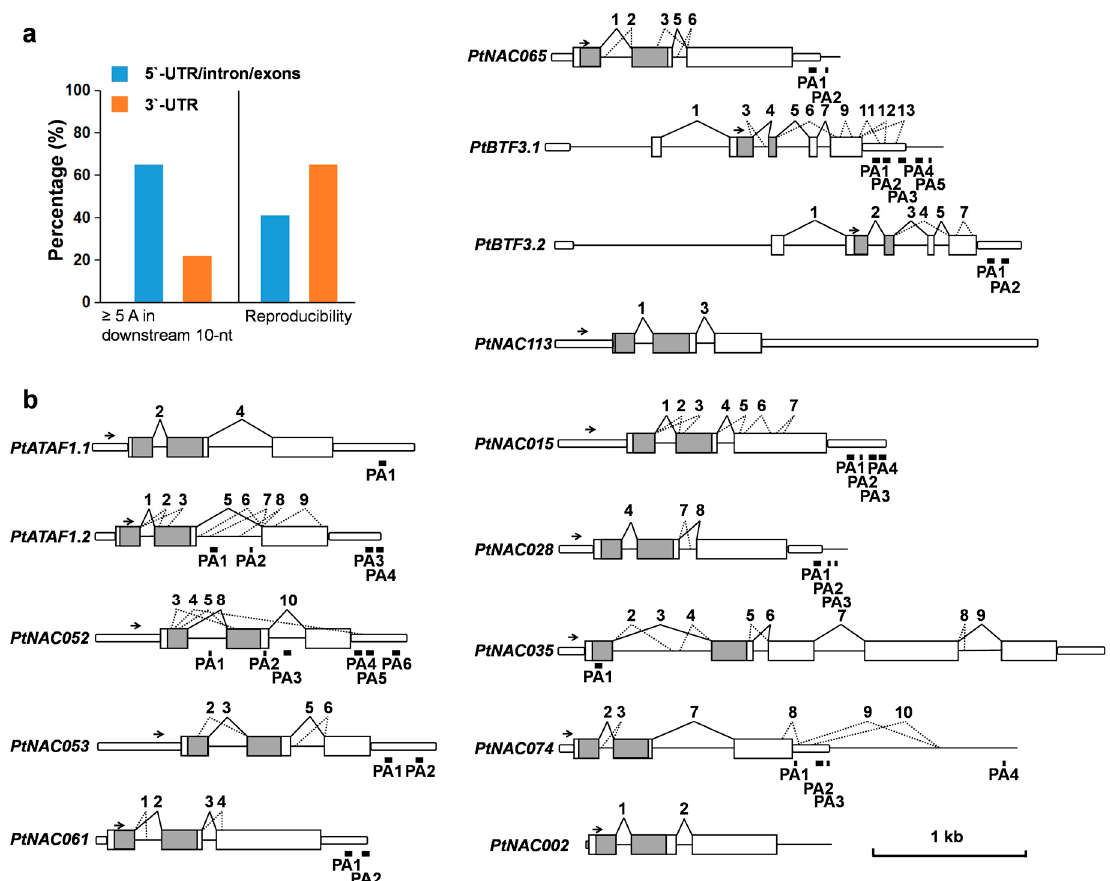
Figure 4. Polyadenylation sites (PASs) and splicing sites of 14 NAC transcription factor genes revealed by 3 ′ -RACE-seq. ( a ) The percentage of ≥ 5 As (adenosines) in a downstream 10 nt window and reproducibility for candidate PASs; ( b ) Schematic representation of splicing sites and PASs. Rectangle: annotated exon; round rectangle: 5 ′ -UTR or 3 ′ -UTR; straight line: annotated intron; grey rectangle: region encoding NAC domain; zigzag full line: well-covered SS; zigzag broken line: poorly covered SS; tops of zigzag lines are number of each SS, which is discontinuous because of removal of non-canonical sites; short and long bold full line below indicates individual PASs and polyadenylation site clusters (PACs), respectively; arrow: position of 3 ′ -RACE inner primers.